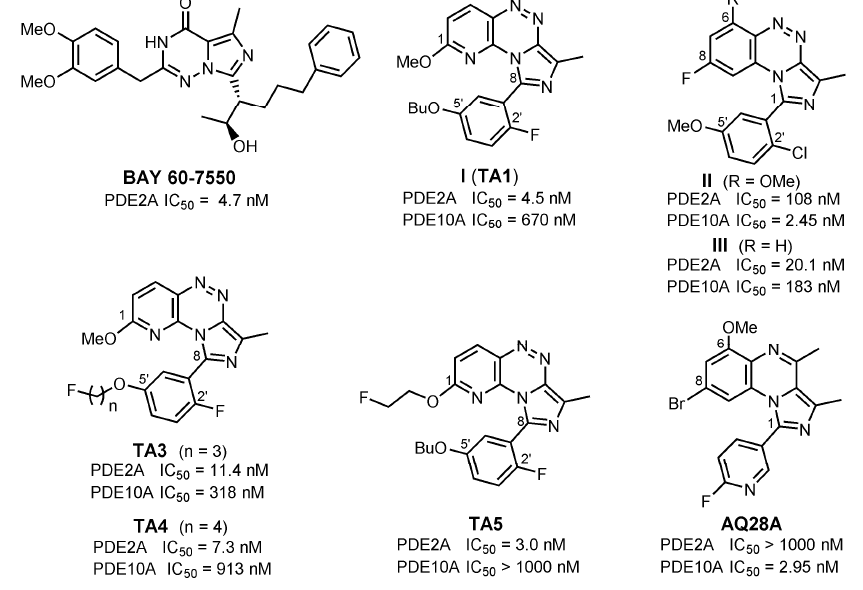
Figure 1. Different PDE inhibitors [15,19–27]. Figure 1. Di ff erent PDE inhibitors